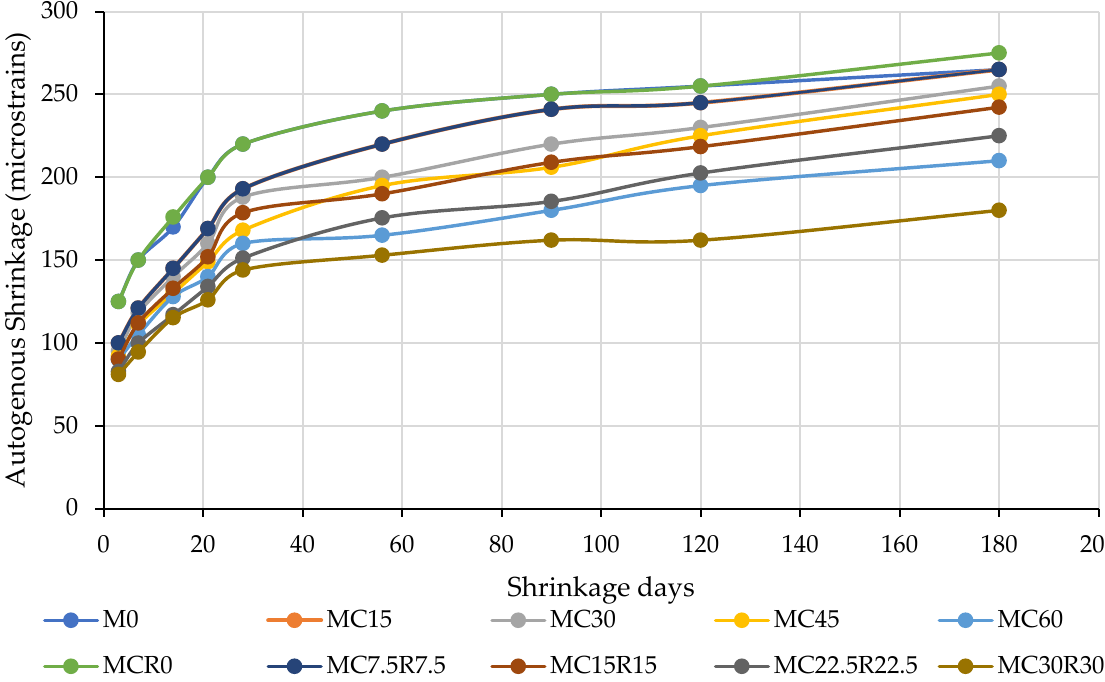
Figure 8. Impact of DCP on dry shrinkage of the slag-based sample.